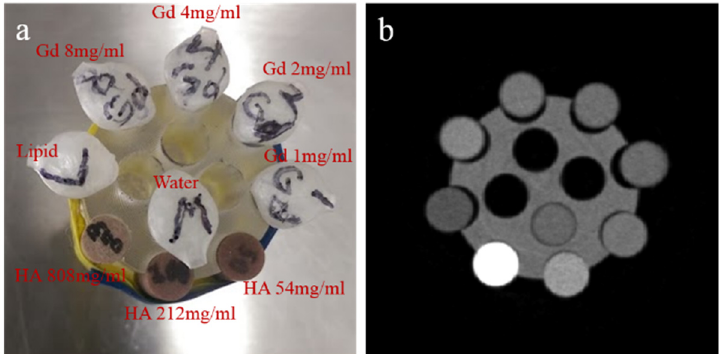
Figure 2. ( a ) Spectroscopic phantom with three 6 mm diameter hydroxyapatite calibration rods (54.3, 211.7 and 808.5 mg/mL) and 6 mm diameter vials of gadolinium (1, 2, 4, 8 mg/mL), oil (canola oil) and distilled water; ( b ) CT image of the phantom.